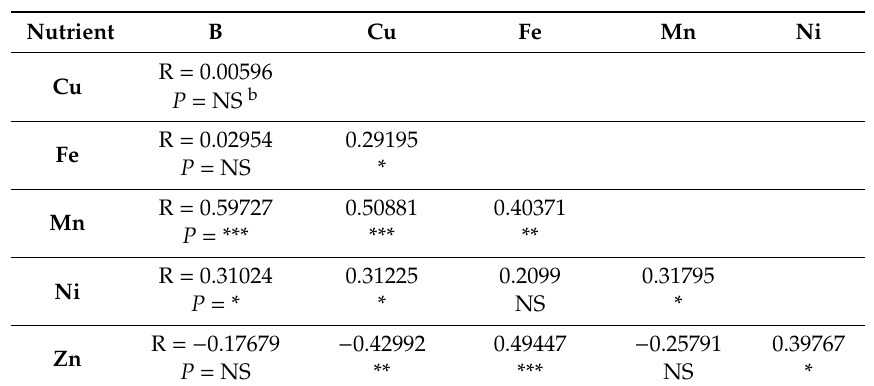
Table 4. Pearson correlation coe ffi cients ( P a and R values) between cottonseed minerals in CS lines grown in SC